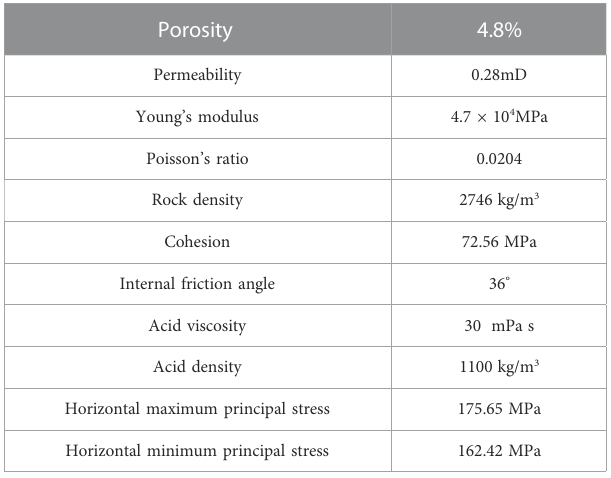
TABLE 3 Input parameters of the model.